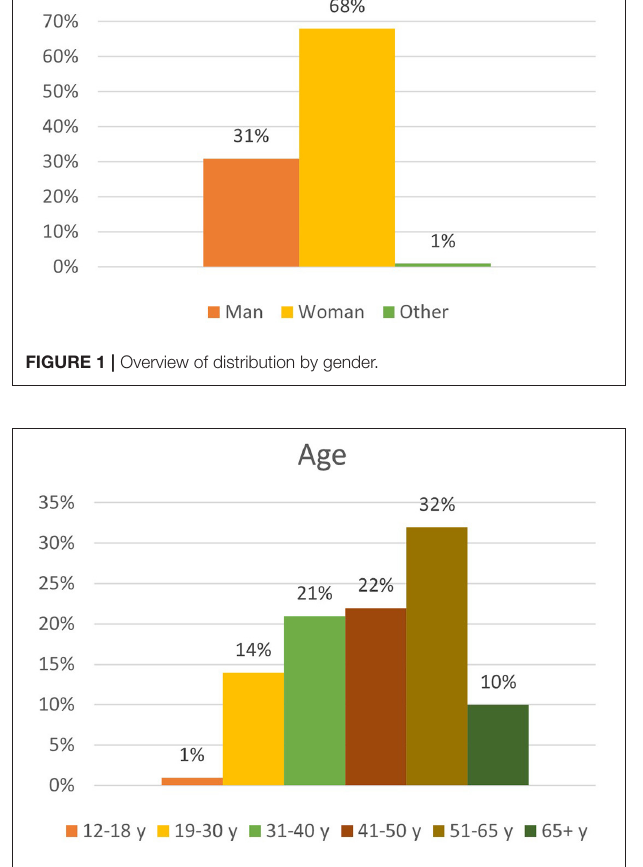
FIGURE 2 | Overview of distribution by age.